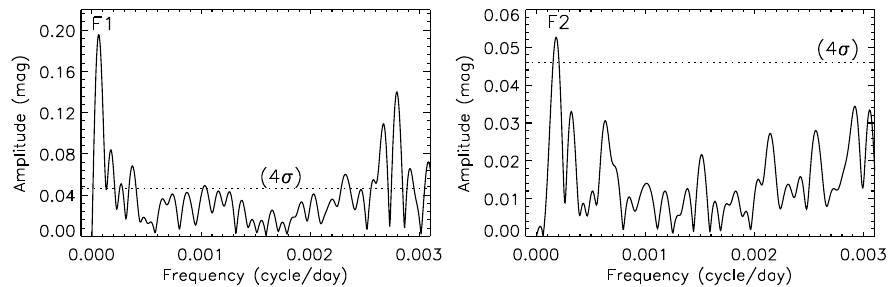
Fig. 3. Results of the frequency analysis. The main frequency (F1) is shown in the left-hand panel. The periodogram in V filter, after the removal of F1, is shown in the right-hand panel. The dashed line denotes 4 (cid:27) level, which is the empirical criterion proposed by Breger et al. (1993) for the detection of signal better than 99.9%